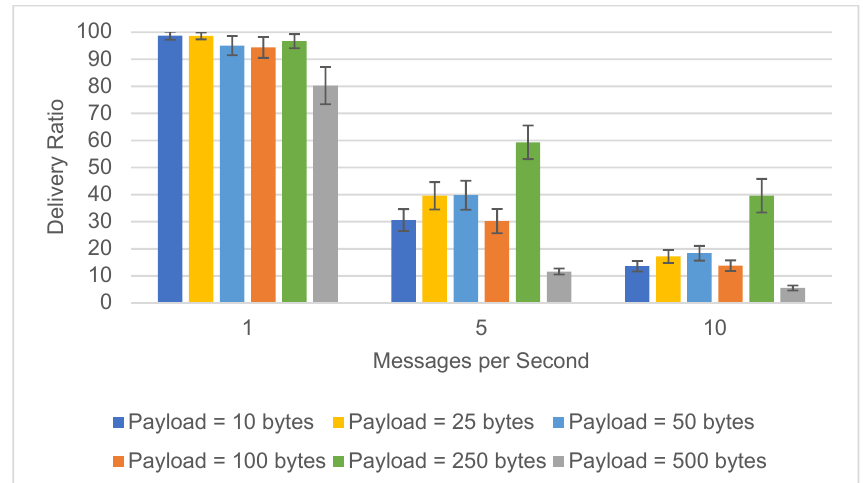
Figure 14. Delivery ratio (%) of messages (3 sensors and 1 destination).